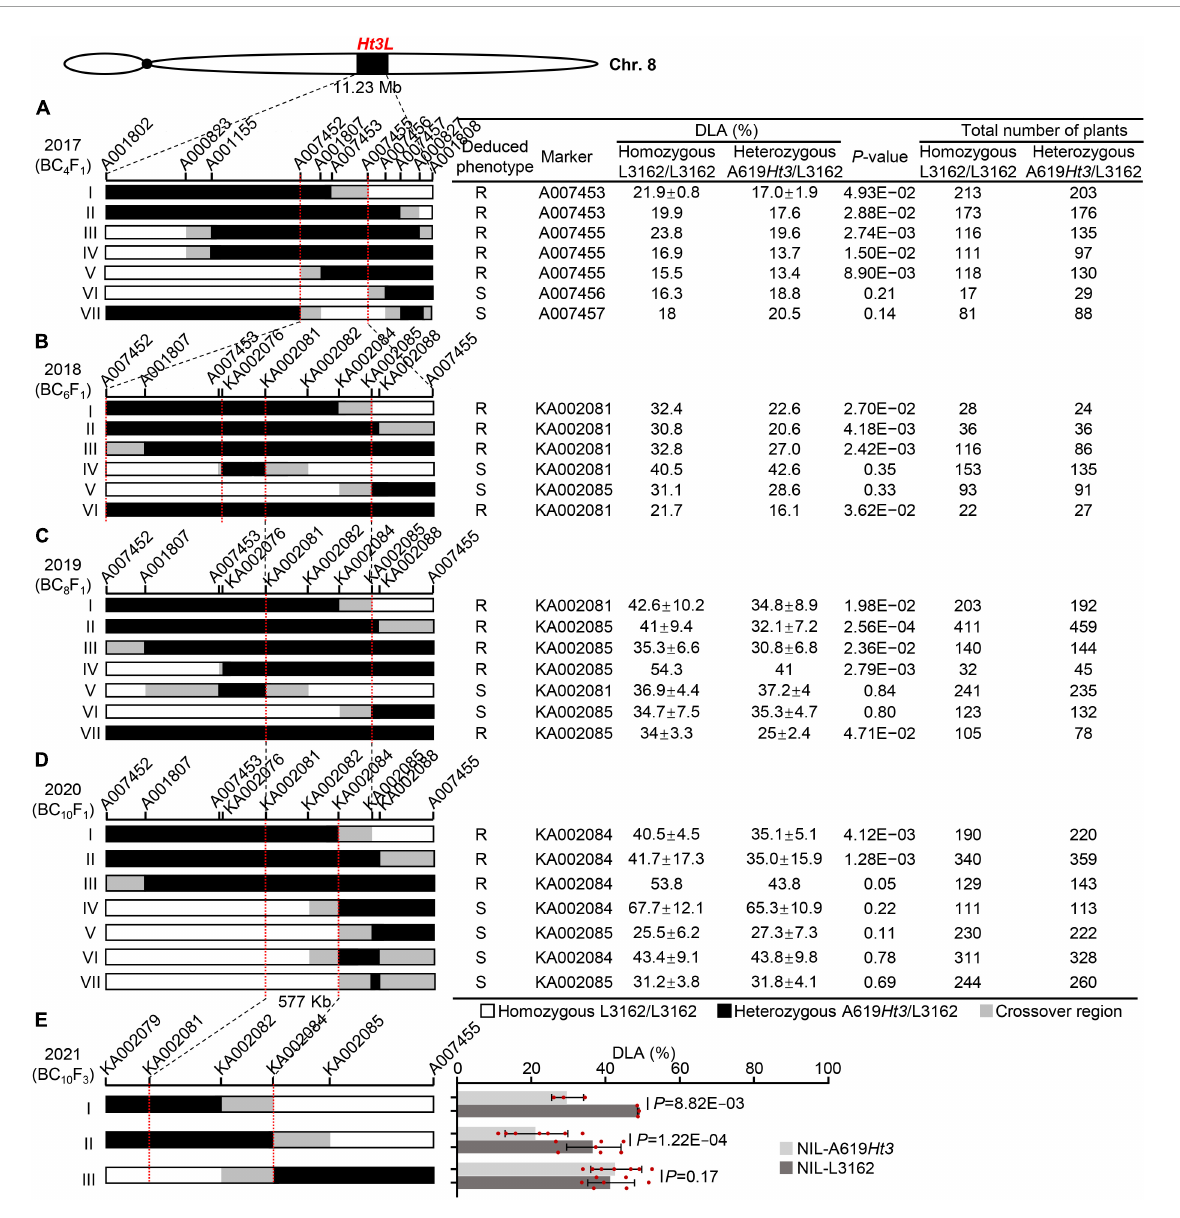
FIGURE3 Sequential fine-mapping of the Ht3L locus by using the recombinant-derived progeny. The vertical bars mark the sites of key molecular markers. The red dotted lines indicate the left and right boundaries of the mapped Ht3L . The chromosomal composition at Ht3L is depicted as black, white, and gray rectangles, representing heterozygous A619 Ht3 /L3162, homozygous L3162/L3162, and recombination breakpoint regions, respectively. The total number of plants refers to all progeny of a given recombinant. The significant difference in DLA among genotypes was calculated using t- test. A significant difference in DLA ( P < 0.05) between heterozygous and homozygous offsprings indicated the presence of Ht3L in the A619 Ht3 donor region, and the corresponding parental recombinants were deduced to be NCLB resistance (R). A P -value > 0.05 indicates that no significant difference in DLA between heterozygous and homozygous offsprings, suggesting the absence of Ht3L in the donor region, and the corresponding recombinants were deduced to be NCLB susceptibility (S). Ht3L was narrowed from an ∼ 11.23-Mb to an ∼ 577-kb region flanked by the markers KA002081 and KA002084 through five rounds of fine-mapping process. (A) Ht3L was initially mapped in bin 8.06 with the physical distance of 11.23-Mb and fine-mapped to an ∼ 2.17-Mb interval with seven BC 4 F 1 recombinants. (B) Ht3L was localized into either A007452/KA002076 or KA002081/KA002085 intervals by using six BC 6 F 1 recombinants. (C) Ht3L was confirmed to be located into the 838-kb KA002081/KA002085 interval by using seven BC 8 F 1 recombinants. (D) Ht3L was narrowed down to a 577-kb interval flanked by markers KA002081 and KA002084 by using seven BC 10 F 1 recombinants. (E) Ht3L was further confirmed to be in a 577-kb interval by using three pairs of